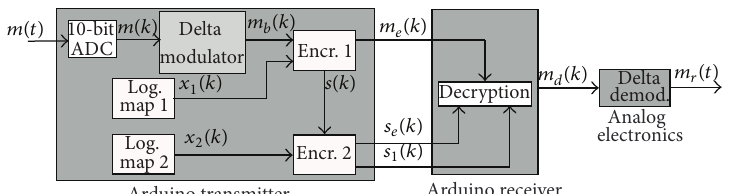
Figure 1: Block diagram of the communication system.